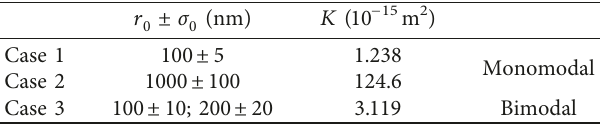
Table 2: Absolute permeability as function of pore-size distributions.